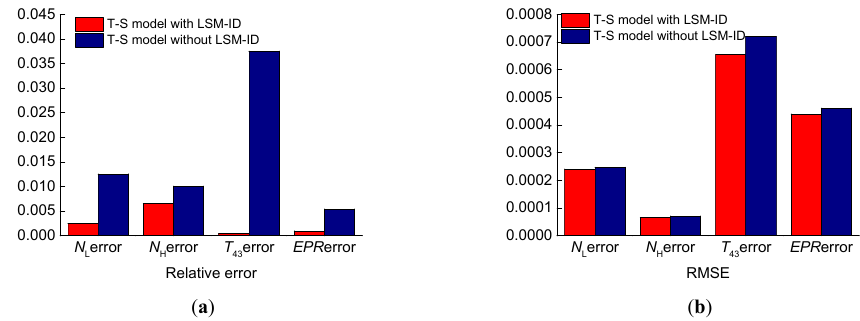
Figure 9. Relative error and RMSE compared with the nonlinear model under 2.5 km and 0.5 Mach. ( a ) Relative errors. ( b ) RMSEs.